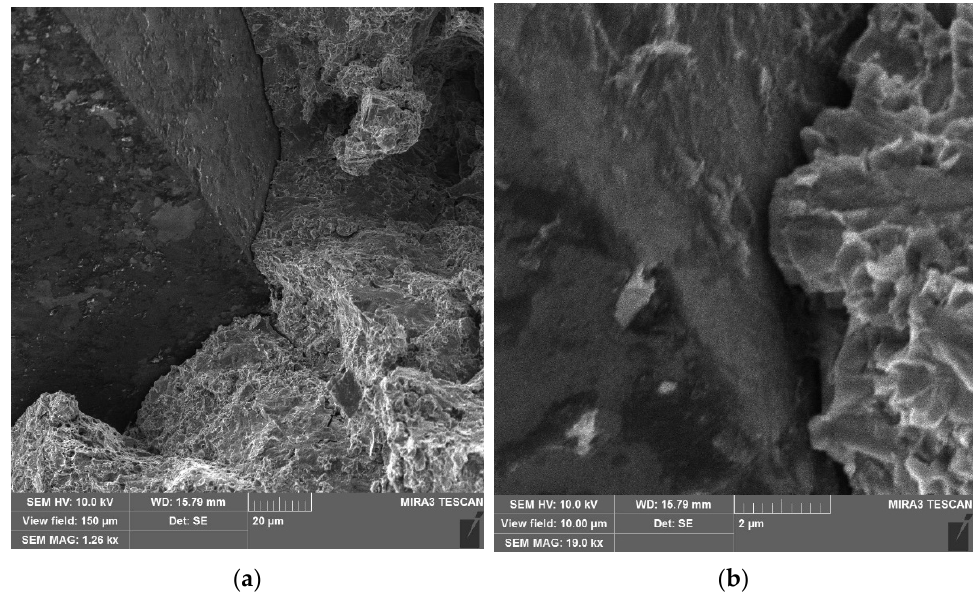
Figure 5. Details of the fracture surface of diamond composite sample 5 at temperature +20 °C, adjacent to the diamond–matrix interface: ( a ) 20 μ m scale; ( b ) 2 μ m scale.